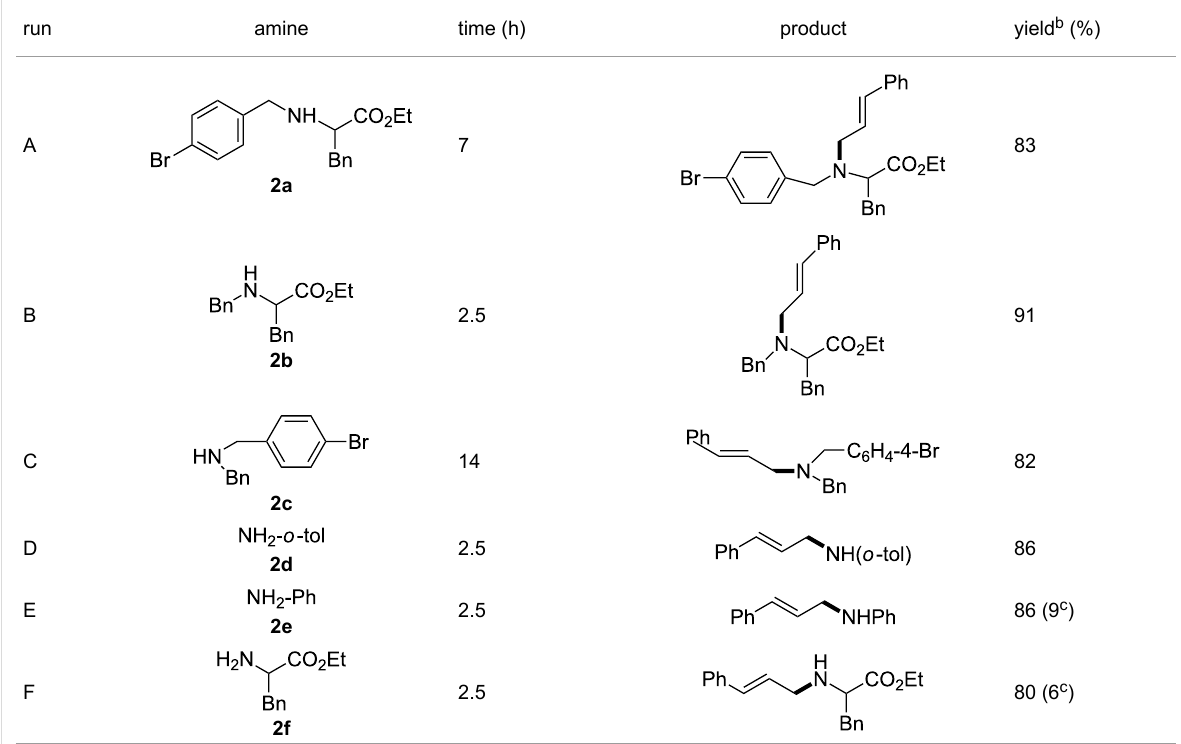
(Table 4): the preferred substrates are